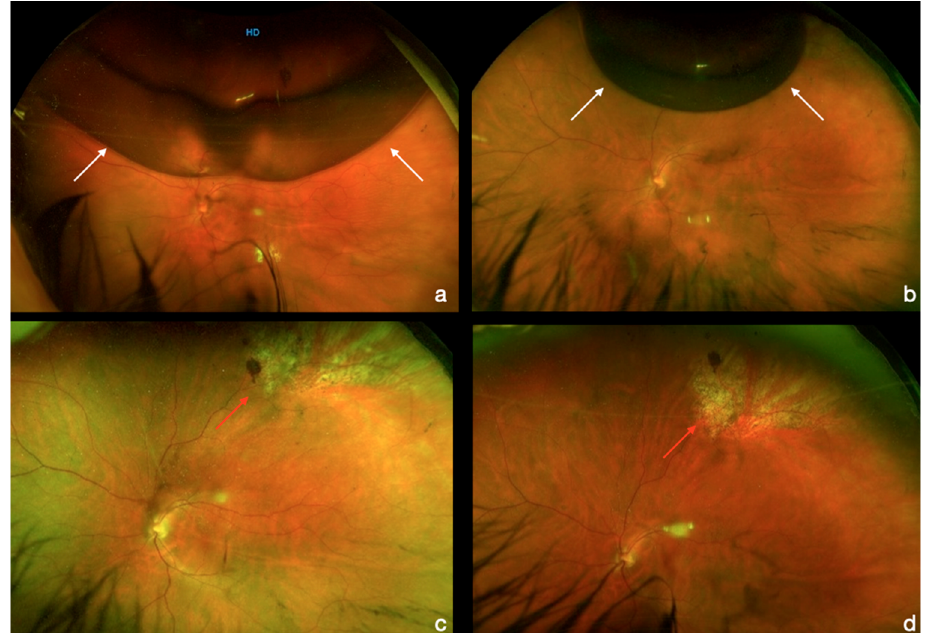
Figure 4. Post-operative day 1 ( a ) and day 7 ( b ) fundus pictures with a progressive reduction in gas filling (white arrows), and fundus pictures at 1 month ( c ) and 6 months ( d ) with cryopexy treatment on the main retinal tear and the retina attached (red